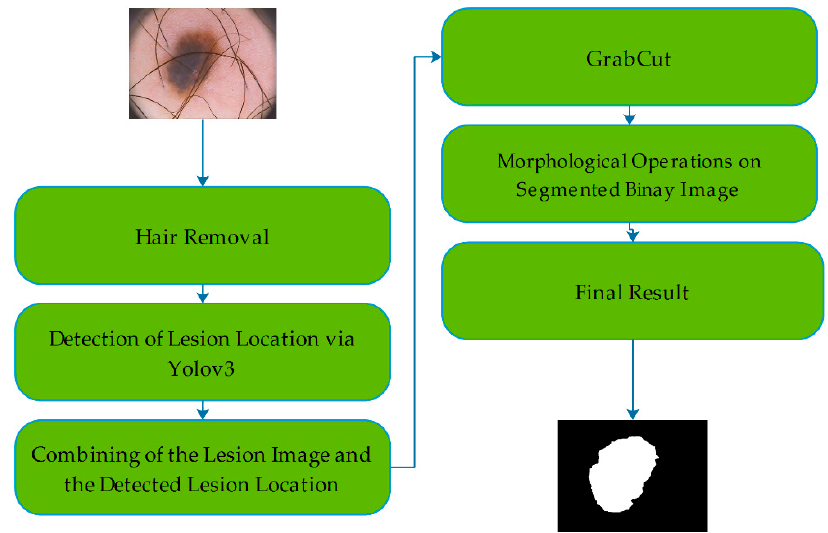
Figure 3. Flow chart of the proposed method including all steps.